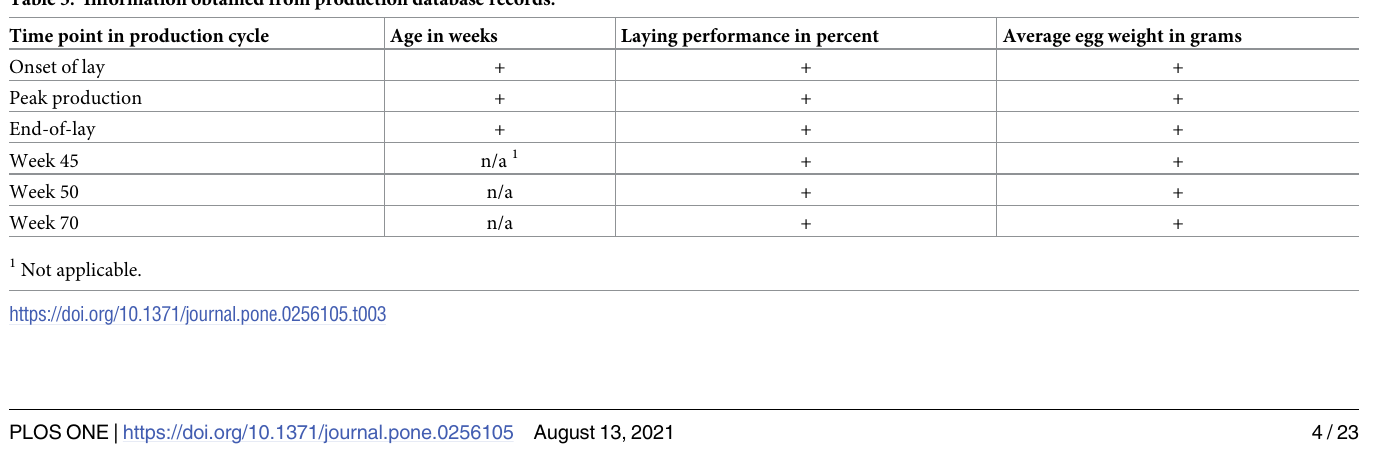
Table 3. Information obtained from production database